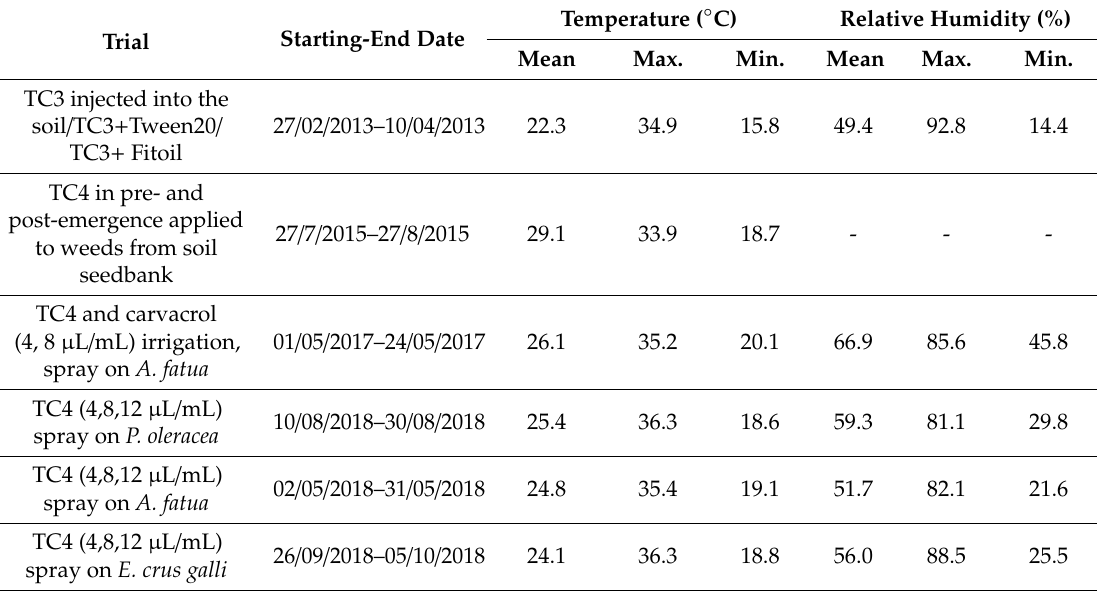
Table 13. Temperature and relative humidity conditions (Mean, Maximum (Max.) and Minimum (Min.)) in the greenhouse during the experiments.